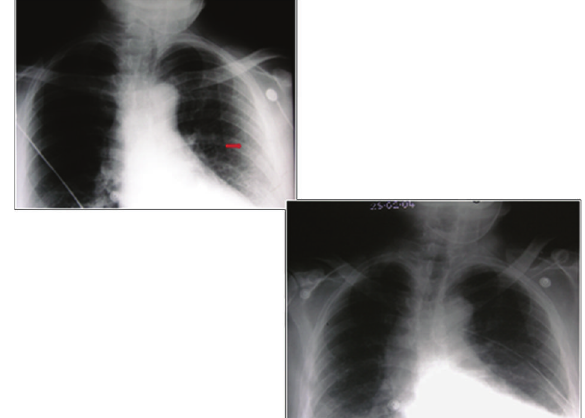
Figure 9: A CXR showing a chest drain placed into a left- sided pseudopneumothorax. Before placement of chest drains, it is essential that pneumothorax mimics be recognized.